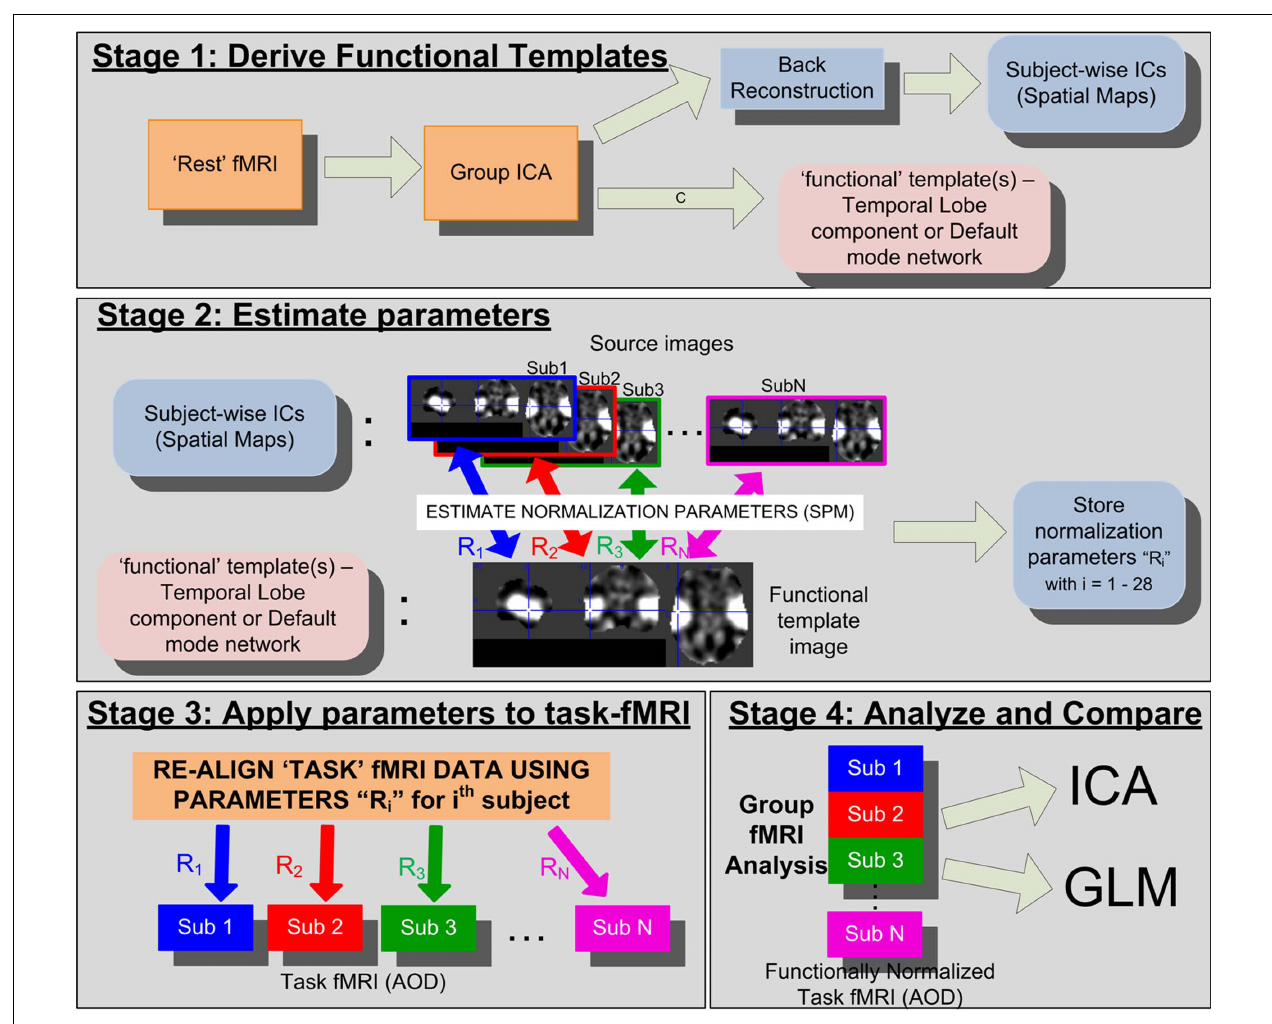
FIGURE 1 | Detailed flowchart of the proposed ICA-fNORM framework illustrating all relevant stages involved. This figure illustrates temporal lobe